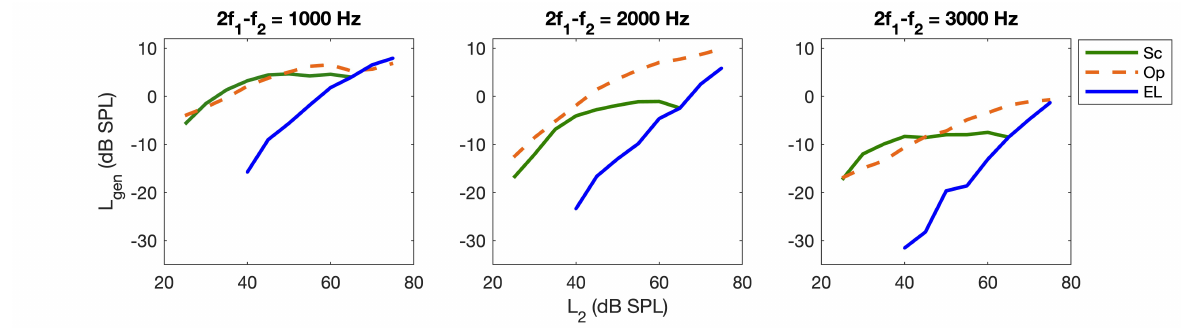
Figure 4. I / O gen at frequencies of 1000, 2000, 3000 Hz for different paradigms (shown in the legend) for